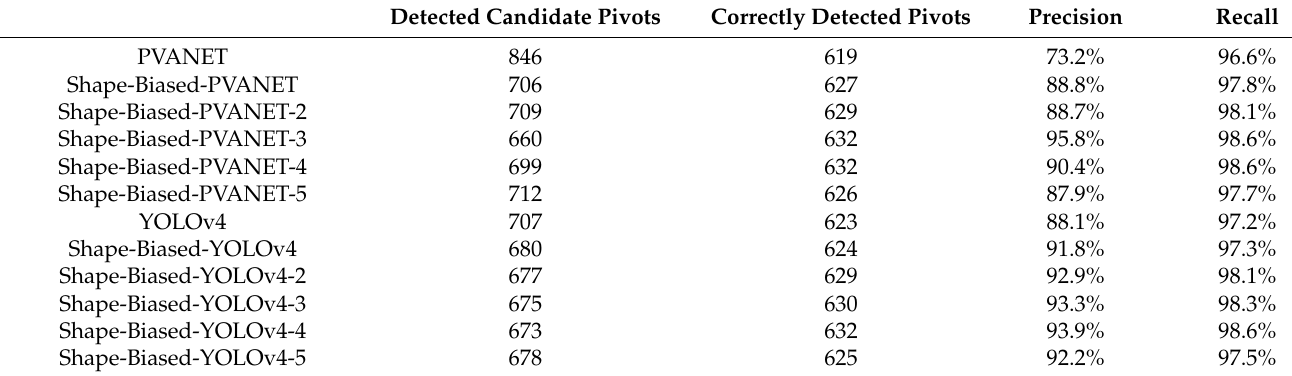
Table 2. The results of PVANET and YOLOv4 with more edge image samples in the training data. Detected Candidate Pivots Correctly Detected Pivots